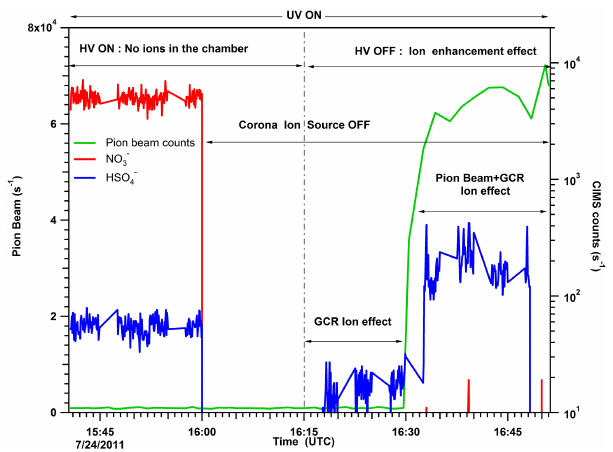
Figure 4. APi-TOF negative ion mass spectrum for a binary 4 H 2 SO 4 –H 2 O (blue) and a pinanediol (red) nucleation experi- ment with almost identical sulfuric acid concentration (6.6 × 10 6 moleculecm − 3 ) . The HSO − signal is increased by a factor of 4 ∼ 2, which confirms that these ions are detected with a higher sen- sitivity if PD is present. Clustering with OxOrg molecules and sub- sequent fragmentation can explain the elevated HSO − count 4